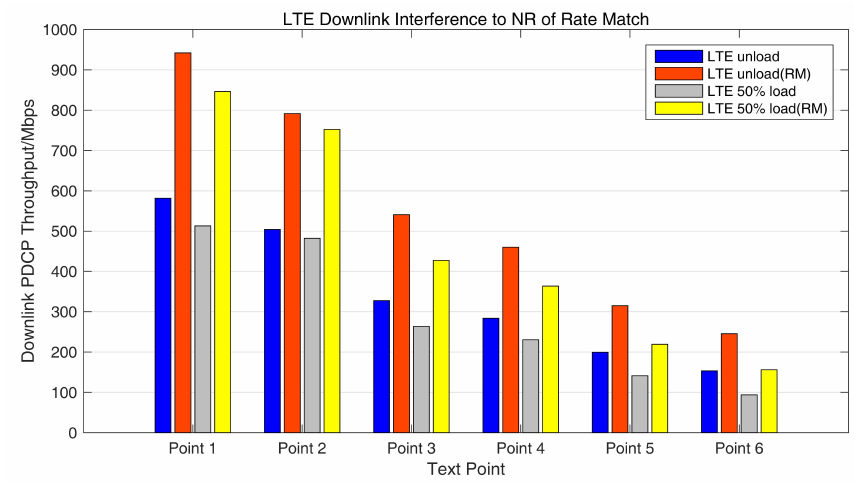
Figure 20. LTE to NR Downlink Interference Test Results after Rate